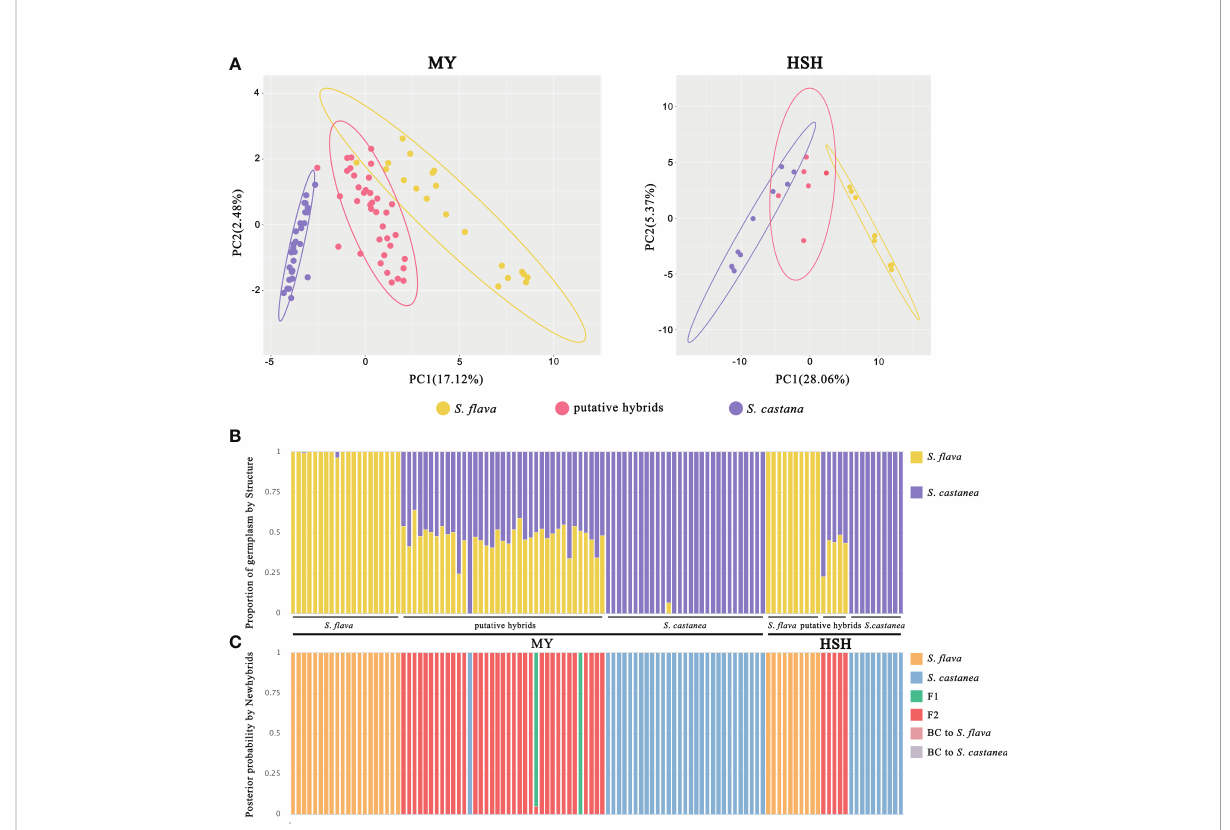
FIGURE 3 Population genetic analyses of S . fl ava , S . casatanea and the putative hybrids based on SNP variation. (A) PCA plot of the fi rst two components for MY and HSH locations. The ellipses represent the 95% con fi dence interval. (B) The STRUCTURE plot with K = 2. (C) Genotype class assignment by Newhybrids based on diagnostic